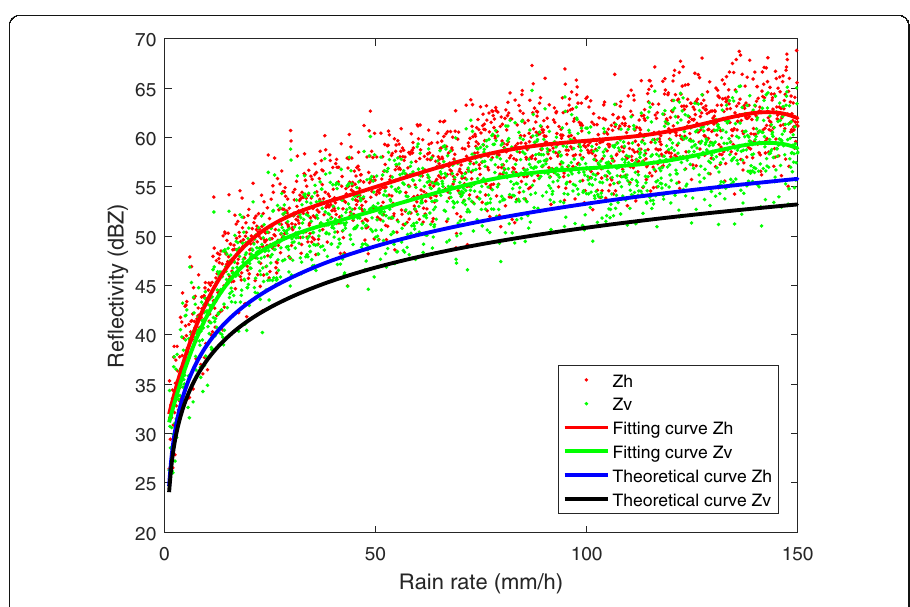
Fig. 10 Relationship between rain rate and